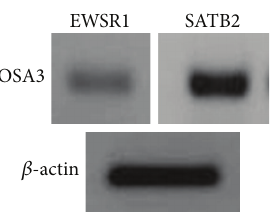
Figure 5: Expression of the SATB2 and EWSR1 genes in OSA3. RT- PCR show the expression of EWSR1 and of SATB2 as characteri- zation of the OSA3 line as properly a cell line of small round cell osteosarcoma.